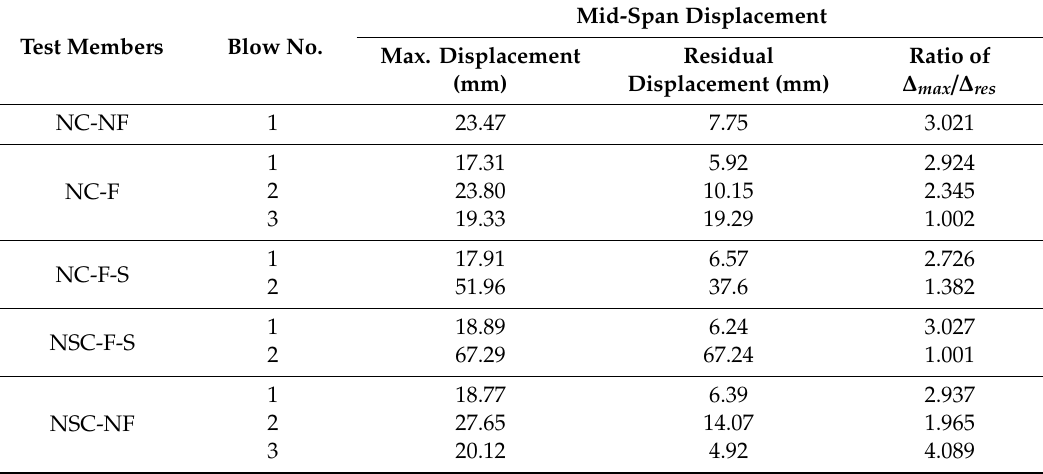
Table 8. Displacements of strengthened concrete slabs under impact